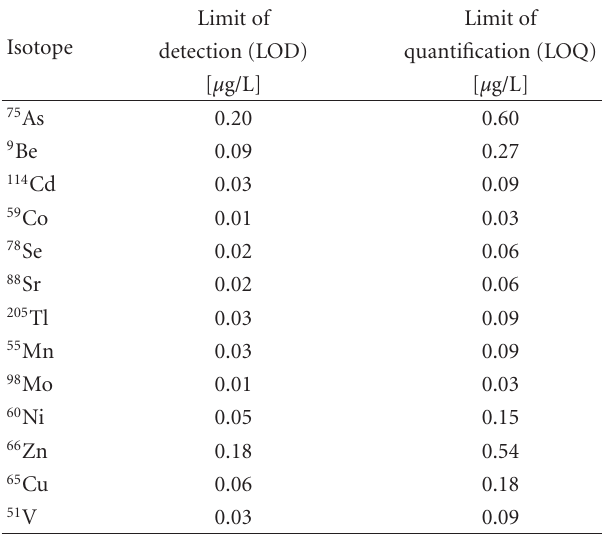
Table 1: The optimum measurement conditions. Table 2: The detection and quantification limits of analyzed ele-